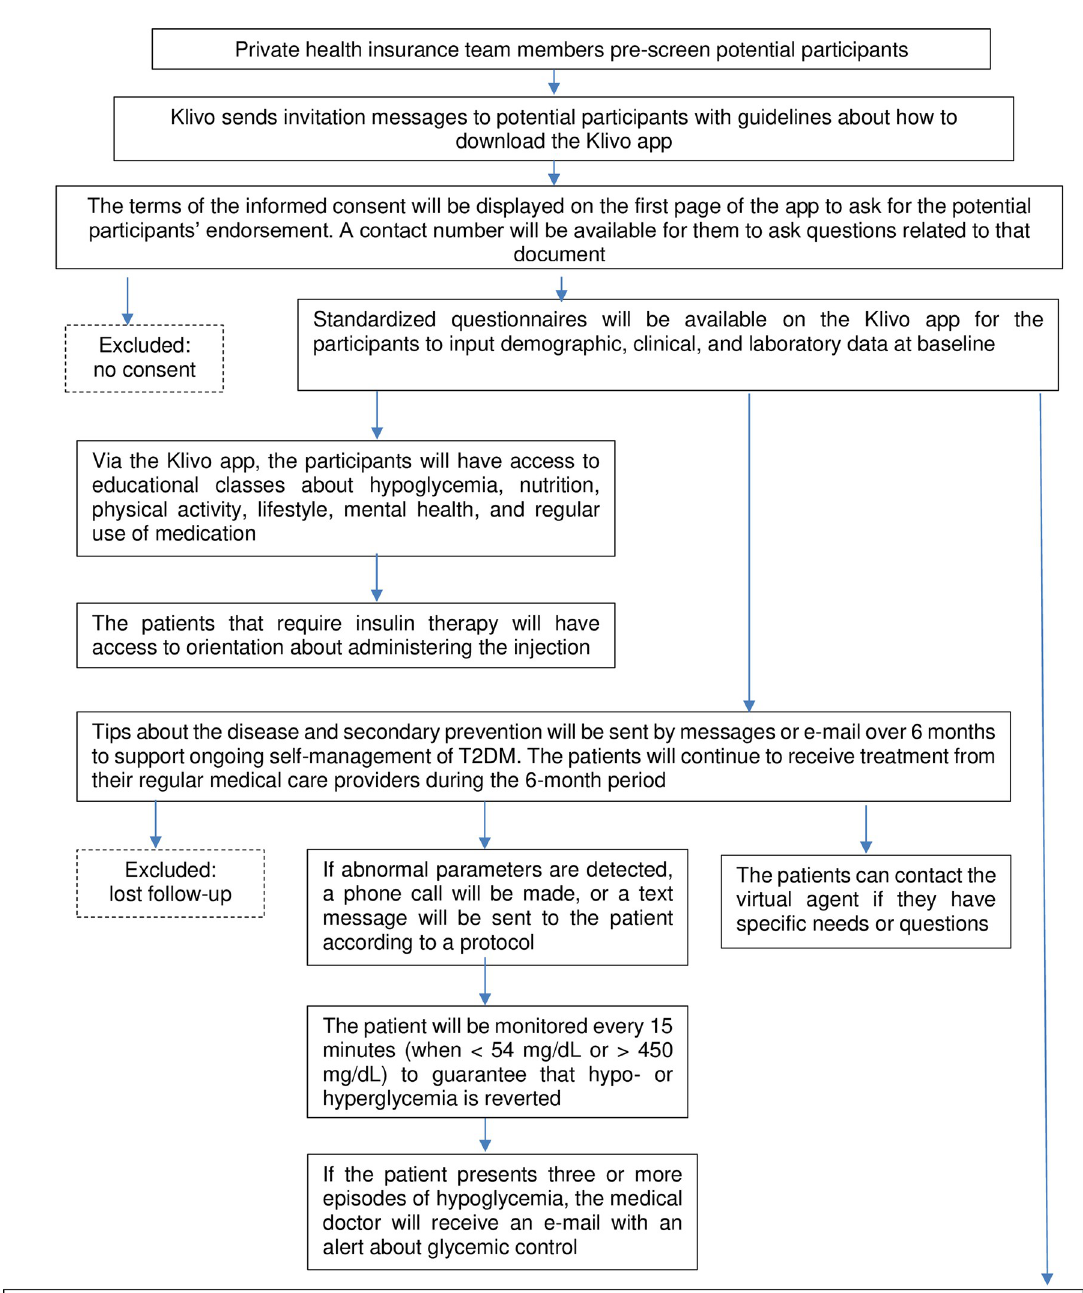
Fig 1. The Klivo Intervention Program (KIPDM) protocol.